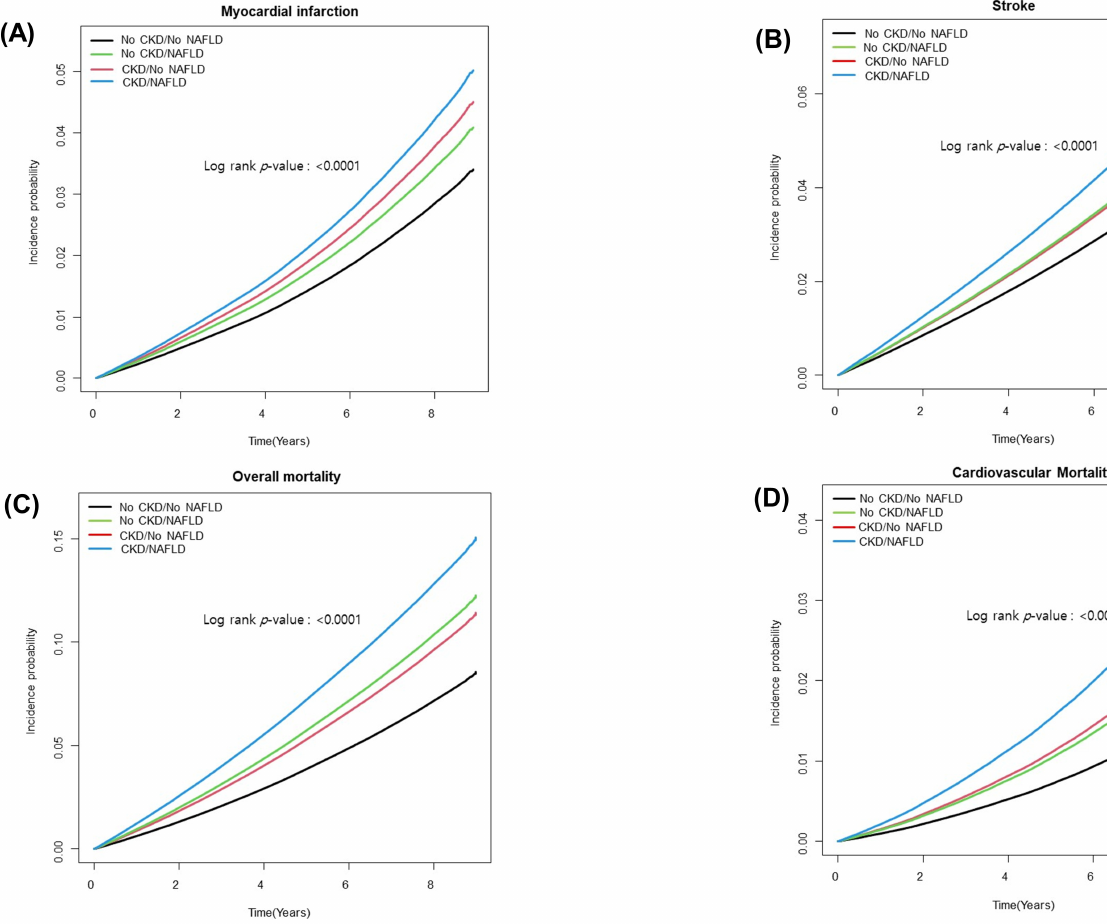
Figure 1. Kaplan–Meier curves showing cumulative event-free survival in patients classified into four groups based on the presence or absence of CKD and NAFLD. ( A ) Myocardial infarction, ( B ) stroke, ( C ) overall mortality, and ( D ) cardiovascular mortality. Cox proportional hazards model were used and adjusted for age, sex, income, alcohol consumption, smoking, regular exercise, income, diabetes mellitus, hypertension, dyslipidemia, DM duration, insulin use, and OHA use. Abbreviations: CI, confidence interval; CKD, chronic kidney disease; HR, hazard ratio; NAFLD, nonalcoholic fatty liver